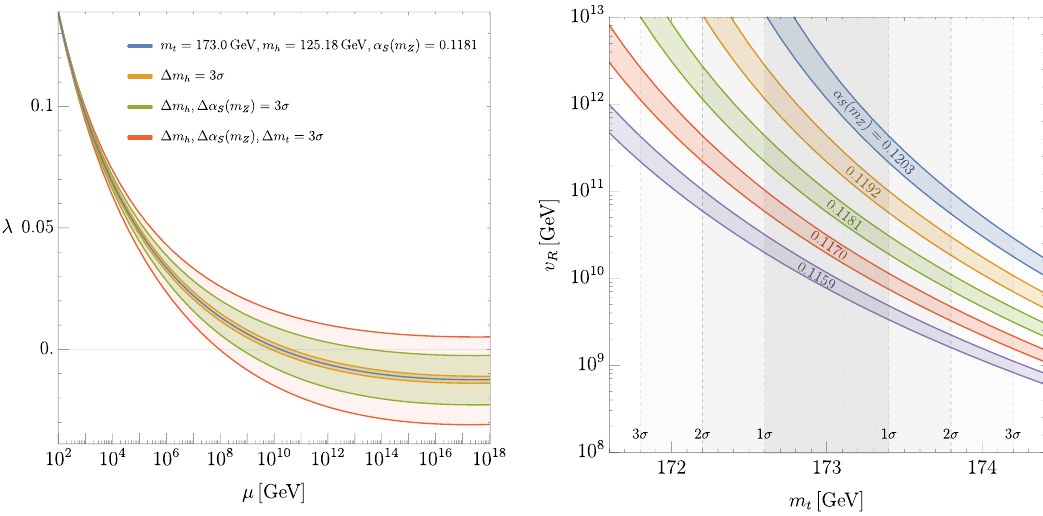
Figure 1 . ( Left ) Running of the SM quartic coupling. ( Right ) Predictions for the scale v R as a function of the top quark mass, m t . Contours of α S ( M Z ) show how the prediction changes with the uncertainty in the QCD couping constant. The thickness of each countour corresponds to ± 1 σ deviation in m h